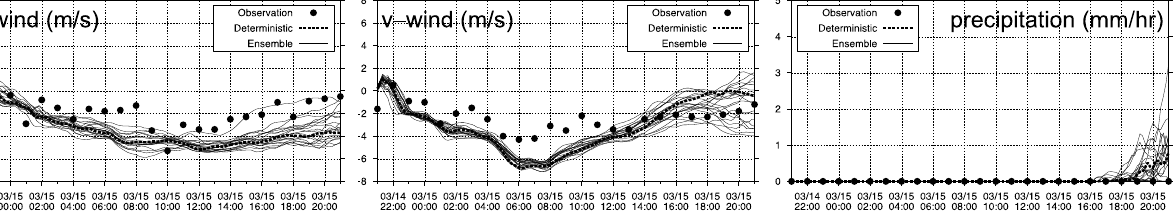
Figure 2. ( a ) Ensemble analysis members and a deterministic analysis member of east-west wind (u component), north-south wind (v component), and precipitation at the model surface layer (below 40 m) of the grid corresponding to Hitachi from 21:00 14 March to 21:00 15 March local time. ( b ) Same as ( a ) except for forecast members, which were initiated at 21:00 14 March local time. Circles indicate AMeDAS observations. Crosses indicate the JMA operational 5 km gridded analysis for the daily weather forecast.